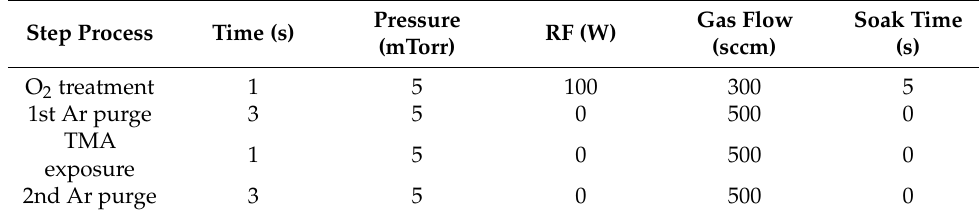
Table 1. Parameters of the ALD process.